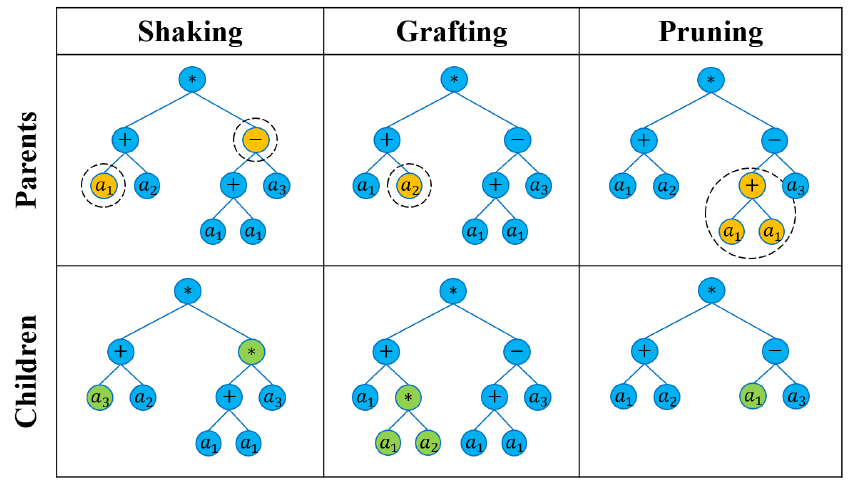
Figure 2. Generating new programs using shaking, grafting and pruning procedures